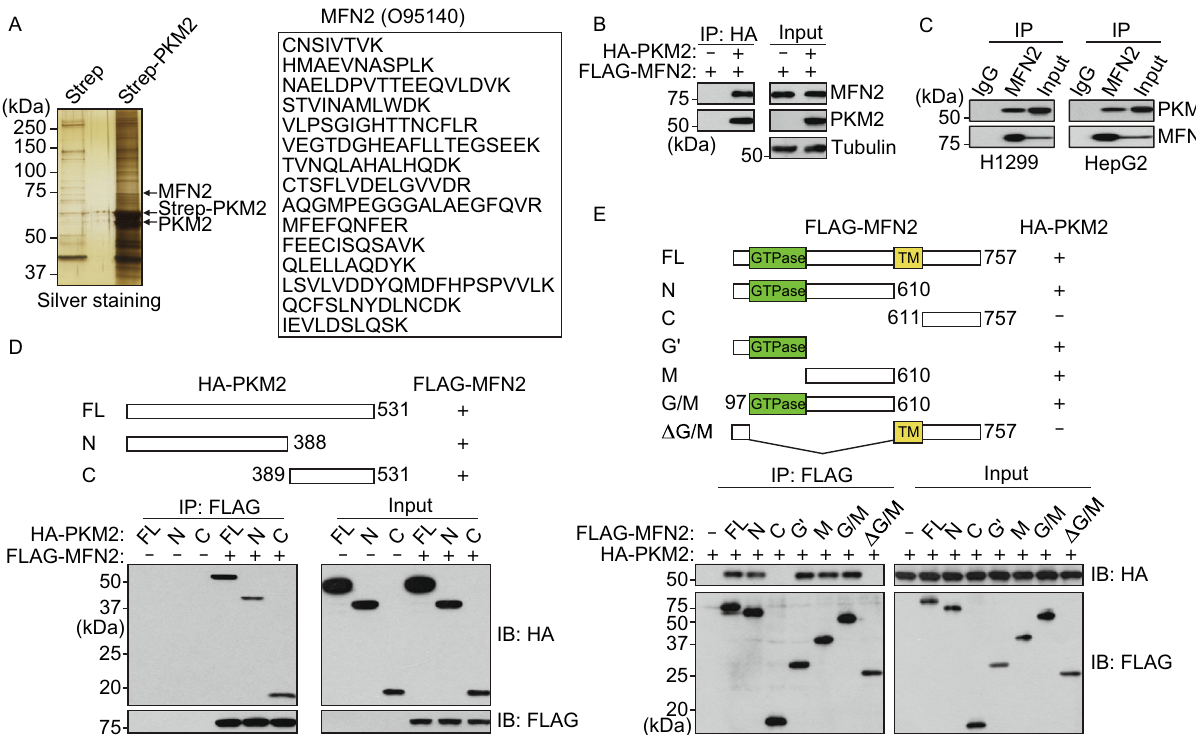
Figure 3. PKM2 binds to MFN2. (A) Left panel: Silver-stained gel showing the proteins that interact with Strep-PKM2 in a pull-down assay in HepG2 cells. Right panel: The peptides from MFN2 that were identi fi ed by mass spectrometry analysis. (B) Co- immunoprecipitation (co-IP) showing the interaction of overexpressed PKM2 and MFN2 in HEK293T cells. (C) Co-IP showing the interaction of endogenous PKM2 and MFN2 in H1299 and HepG2 cells. (D) Deletion analysis of the regions in PKM2 is required for the PKM2:MFN2 interaction. Interaction-competent PKM2 polypeptides are indicated by (+) in each schematic. (E) Deletion analysis of the regions in MFN2 is required for the PKM2:MFN2 interaction. Interaction-competent MFN2 polypeptides are indicated by (+)